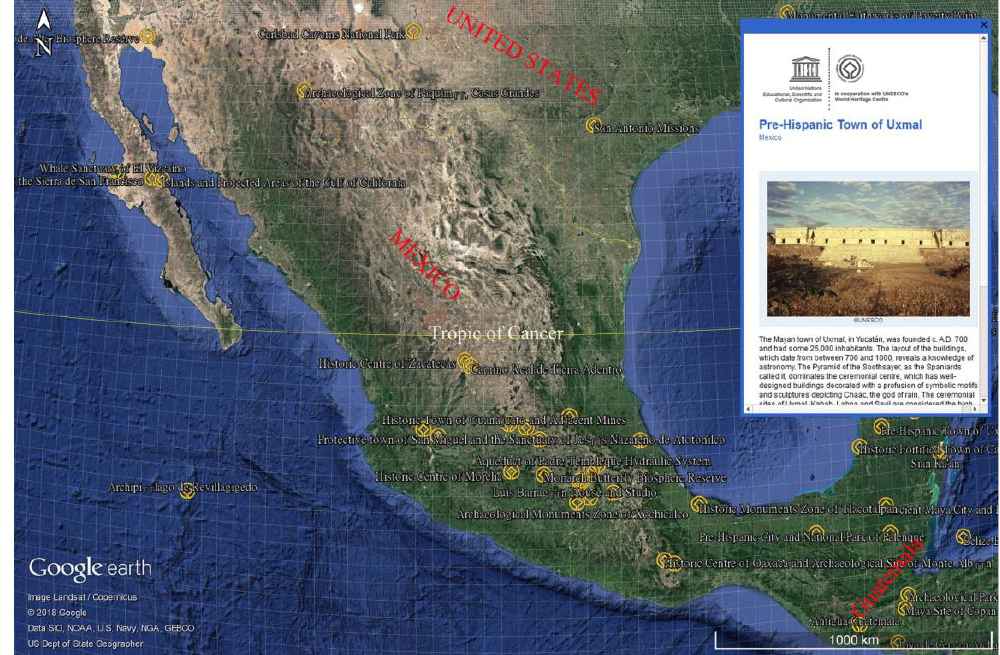
Figure 4. Visualization of Mexico’s WHSs in GE. The original EXCEL file can be downloaded from http://whc.unesco.org/, copyright © 1992–2017 UNESCO/World Heritage Centre.